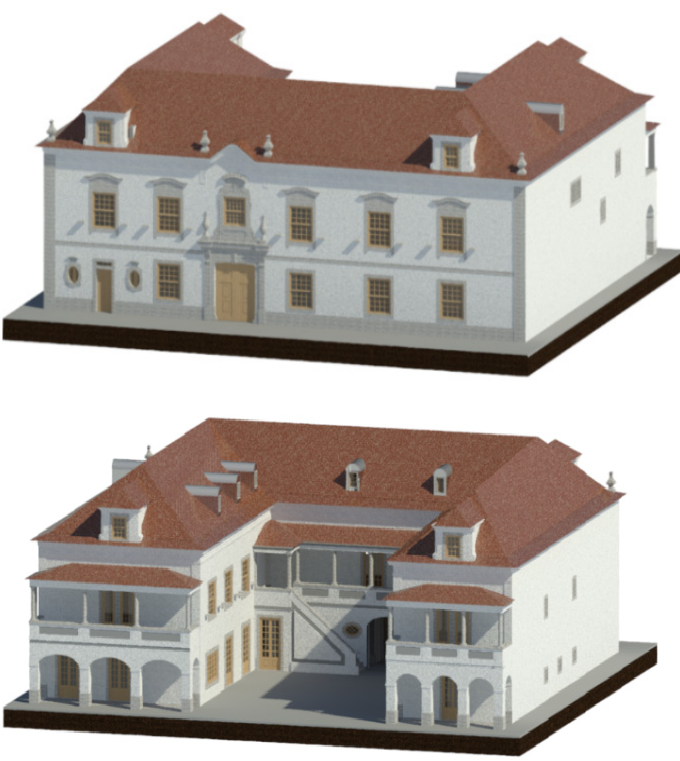
Figure 31. Final architectural